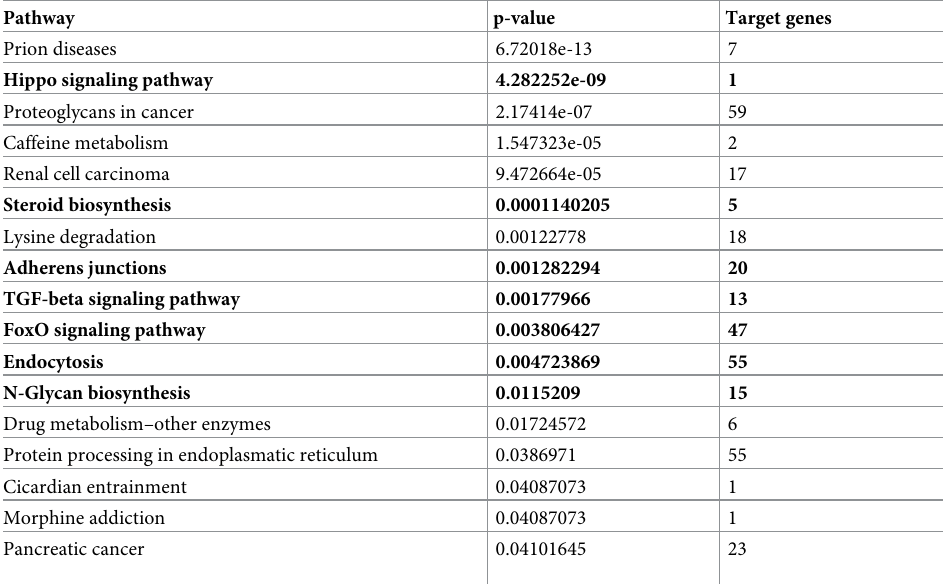
Table 3. Statistically significant union pathways refer to the miRNAs with a decreased expression on day 1. Pathway